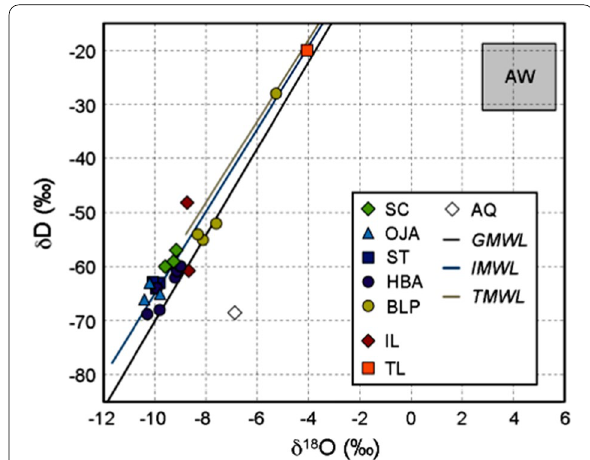
Fig. 5 δ 18 O vs δD for the thermal springs and Irazú–Turrialba lake waters compared with meteoric waters ( GMWL global meteoric water line, IMWL Irazú meteoric water line, TMWL Turrialba meteoric water line) and fumaroles ( AQ Arbol Quemado). Values for the Irazú fumarole are out of scale (δ 18 O 19.9 ‰, δD 122 ‰). The = − = − “andesitic water” end‑member (AW) is also